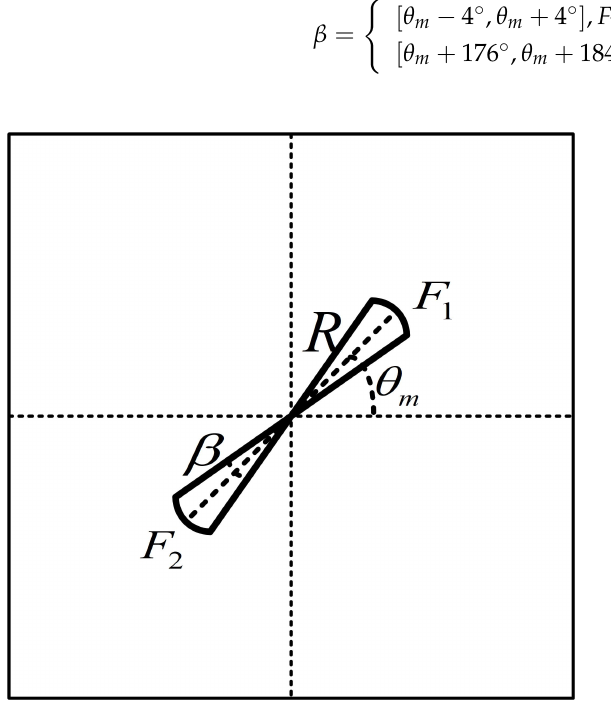
Figure 6. Fan-type